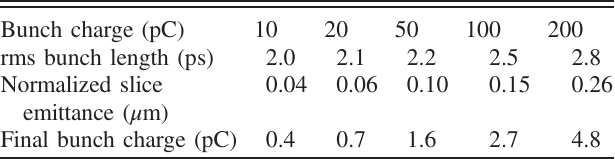
TABLE I. Summary of bunch parameters at the entrance of the